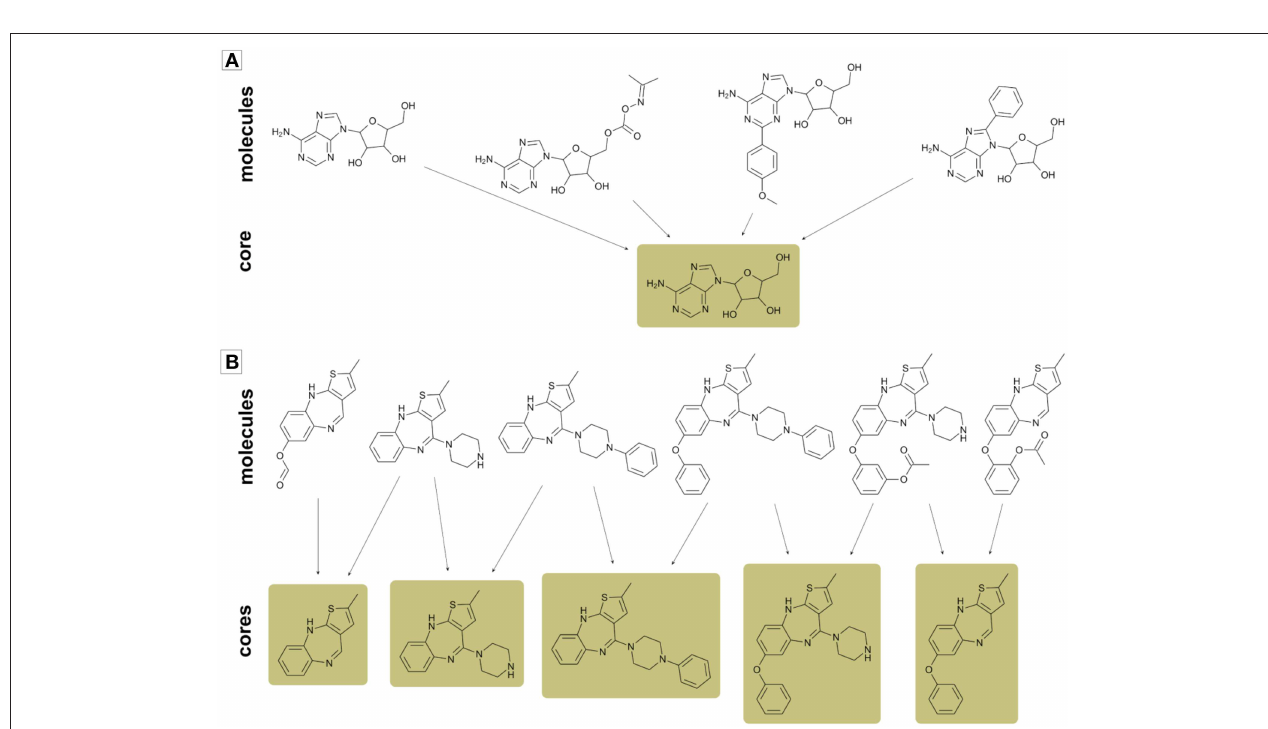
FIGURE 3 | Examples of two analog series with multiple compounds and cores. (A) Analog series that can be summarized in a single core; (B) Analog series formed by multiple cores. In case (B) a single core is not enough for summarizing all information in an analog series.